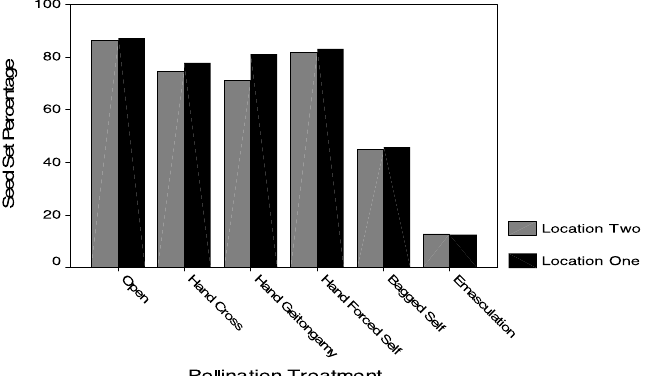
Fig. 5 - Nigella sativa seed set percentage upon pollination treatments in both locations, season